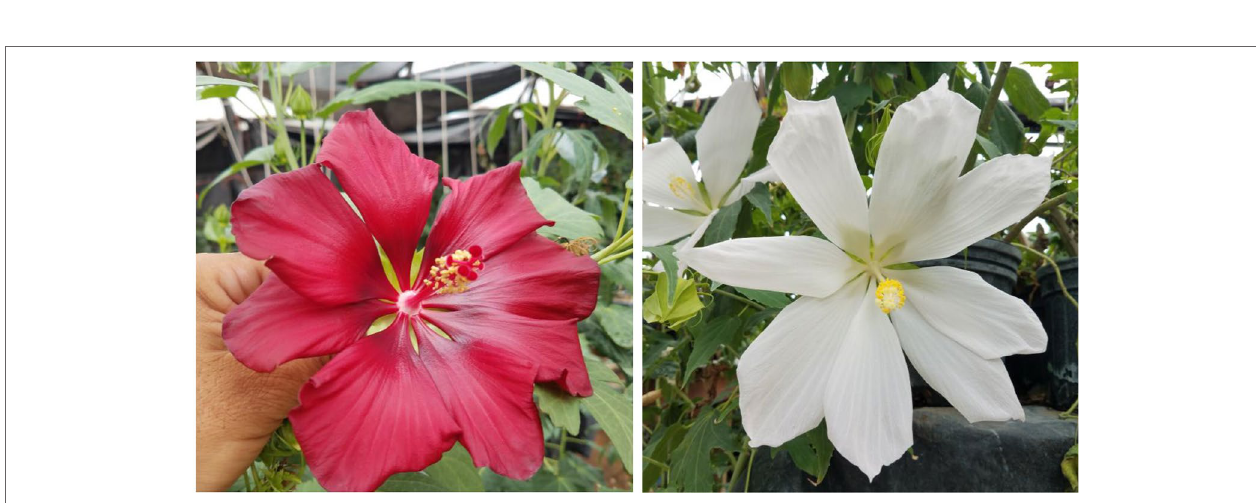
FIGURe 11 | Examples of H. x moscheutos hybrids that tend to produce flowers with more than the regular five petals: “ST199-2” (left) and “16751 GR” (right). Photo credits: Dariusz P. Malinowski.